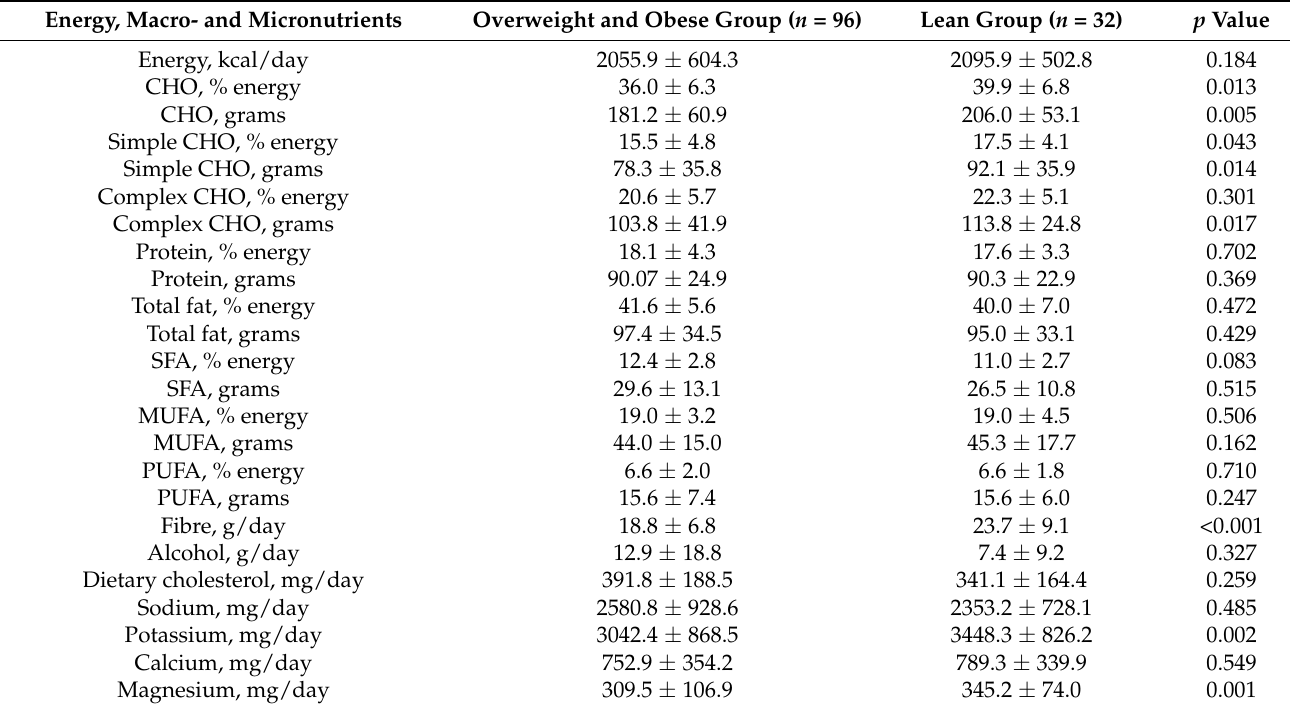
CHO, carbohydrates; SFA, saturated fatty acids; MUFA, monounsaturated fatty acids; PUFA, polyunsaturated fatty acids. Data expressed as Mean ± standard deviation. Differences in categorical variables were examined using chi-squared analysis and presented as percentage (%). Differences in continuous variables were examined using T-Student for parametric variables and using U the Mann-Whitney for non-parametric variables. Statistical significance was set at p Value <